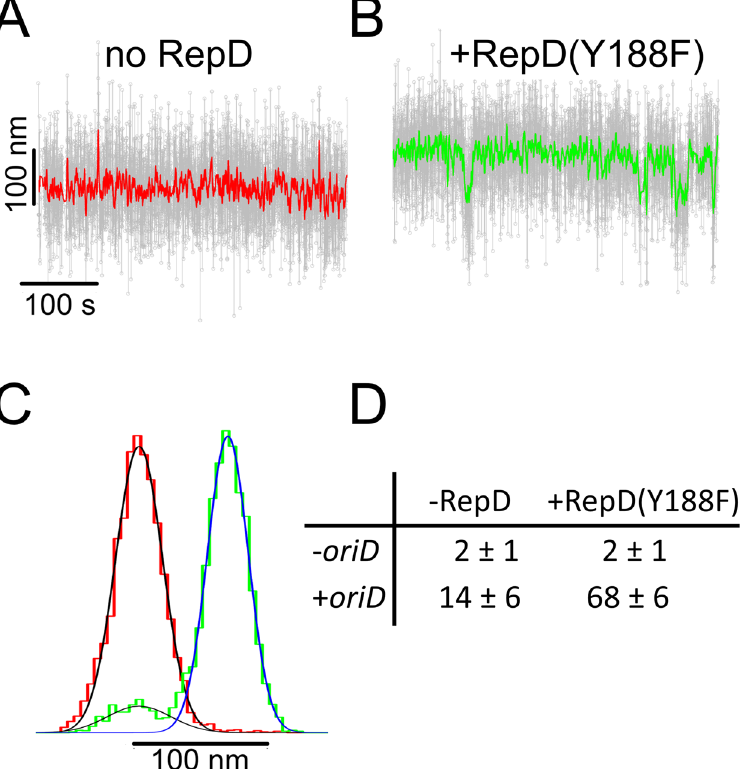
Figure 6. RepDY188F stabilizes hairpin formation at oriD . ( A ) A 4-kb oriD DNA molecule, held at the conditions when DNA fluctuations are still sparse ( − 10 turns 0.67 pN), shows occasional elongation events (i.e. upward movements). Raw data is shown as grey circles; colored lines are 25-point running averages. ( B ) After addition of RepDY188F (60 nM) the DNA molecule is biased towards the elongated state and the mean length is ~80 nm longer (equivalent to loss of about 1.5 turns of writhe) and now occasionally exhibits downward movements. ( C ) The averaged, z-displacement data for data shown in records “A” (red) and “B” (green) are plotted as histograms with dual Gaussian fits (continuous lines, see Fig. S3 for further details). The area under the curves gives the fraction of time spent in each state. ( D ) The fraction of time (%) spent in the elongated (hairpin) state is tabulated for different conditions, + / − RepDY188F (60 nM) in the bathing solution and + / − oriD site in the DNA template (n = 25 DNA molecules for each condition). All experiments were at − 10 turns negative supercoiling (i.e. σ = − 2.6%), F = 0.67 pN and 23